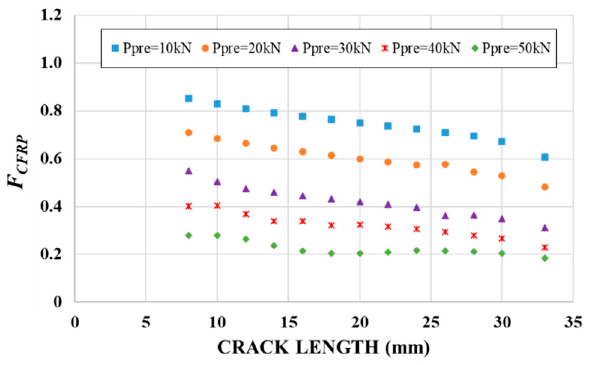
Figure 14. Evolution of the reduction factor F CFRP with the pre-stressing force of the CFRP laminate. As the pre-stressing force increased, the F CFRP -a curve starts to flatten. This was due to the compressive stress that took place in the thickness of the steel plate, as shown in Figure 15.